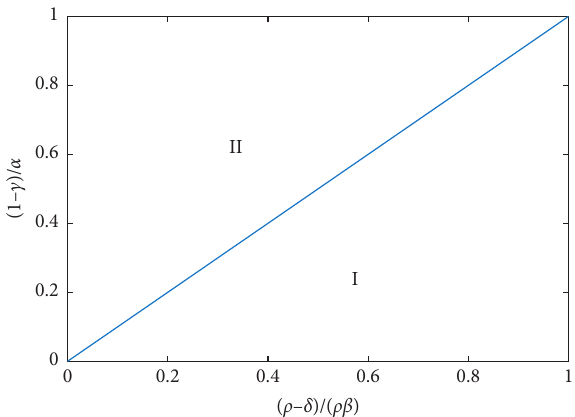
Figure 2: Regions for equilibrium points of system